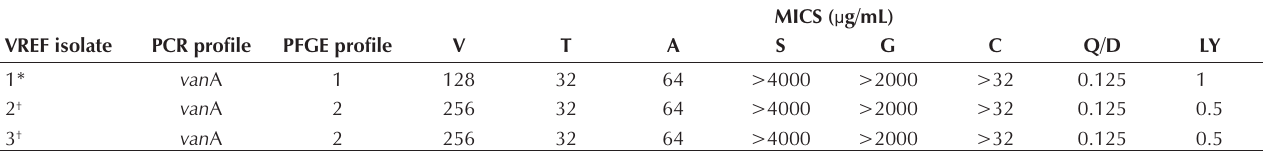
TABLE 1 Phenotypic and genotypic characteristics of the three vancomycin-resistant Enterococcus faecium (VREF) isolates identified as colonizers of the lower gastrointestinal tract of patients in Manitoba hospitals between January and December 1997